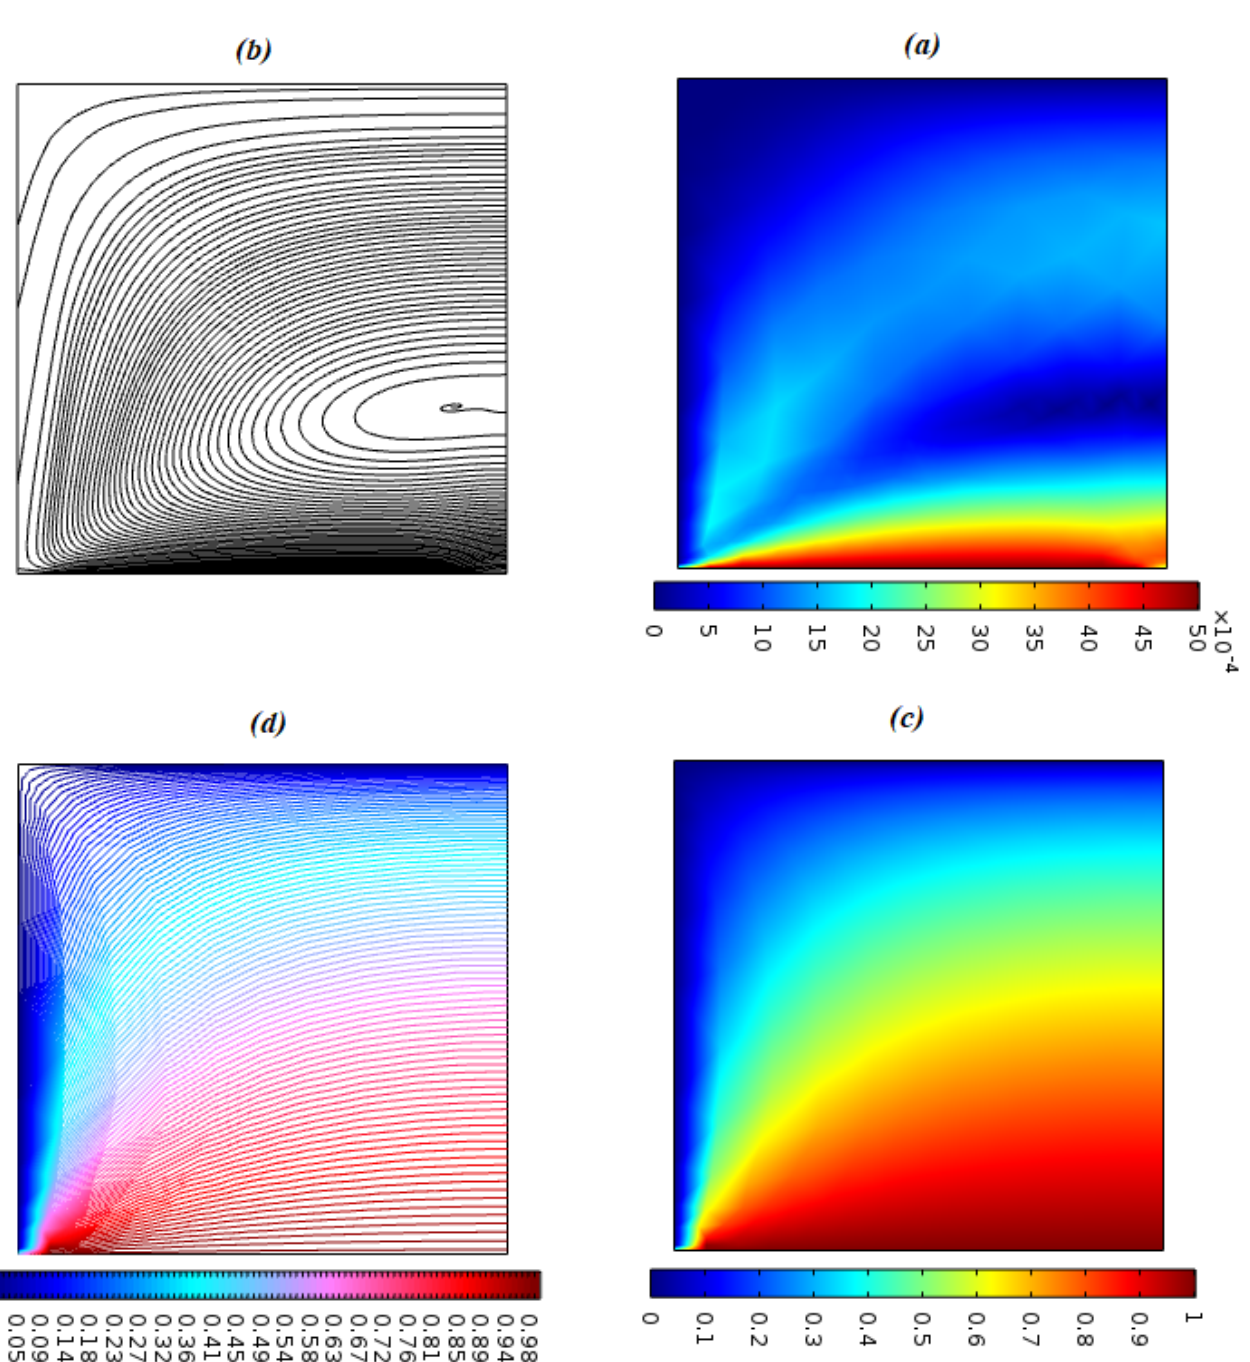
Figure 9. ( a ) Surface plot for velocity, ( b ) streamlines, ( c ) surface plot for temperature, ( d ) isothermal Figure 9. (𝐚) Surface plot for velocity, (𝐛) streamlines, (𝐜) surface plot for temperature, (𝐝) iso- contours using software with U w = 0.005, k ( T ) = 90 ( 1 + 30 T ) , β = 0.7, E 1 = 100, M = 0.5, E c = thermal contours using software with 𝑈 (cid:3050) = 0.005, 𝑘(𝑇) = 90(1 + 30𝑇), 𝛽 = 0.7, 𝐸 (cid:2869) = 100, 𝑀 = = 0.7 . 0.5, 𝐸 (cid:3030)